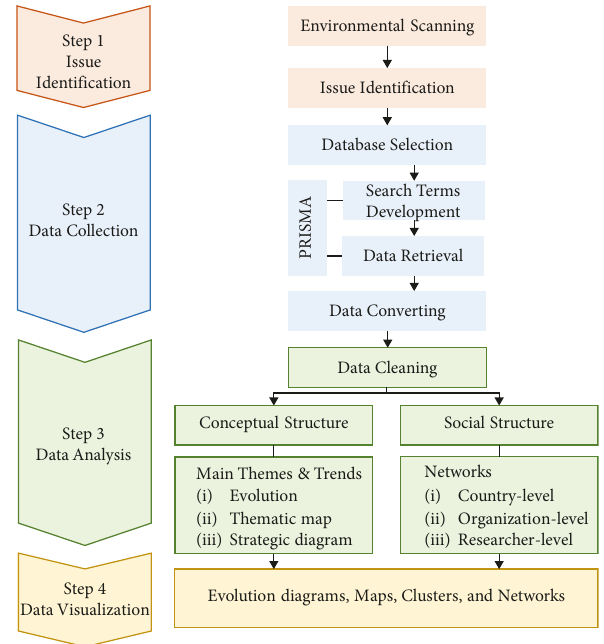
Figure 1: The process of scientometric